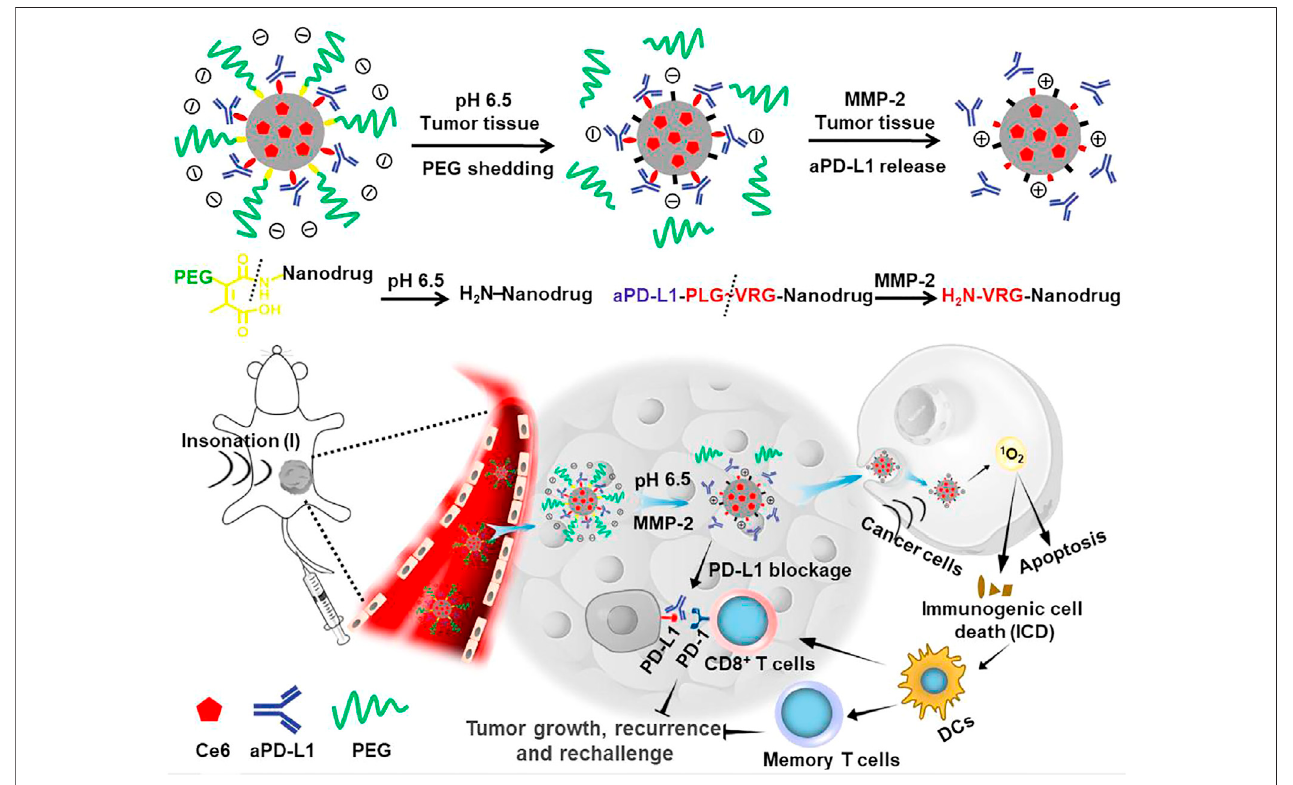
FIGURE 1 | Schematic illustration of the sensitivity and in vivo performance of the pH and MMP-2 dual-sensitive PEG-coated nanodrugs for tumor-targeting combinational SDT and immunotherapy of cancer. Reproduced, with permission, from Huang et al. (2021). Copyright 2021, Elsevier.